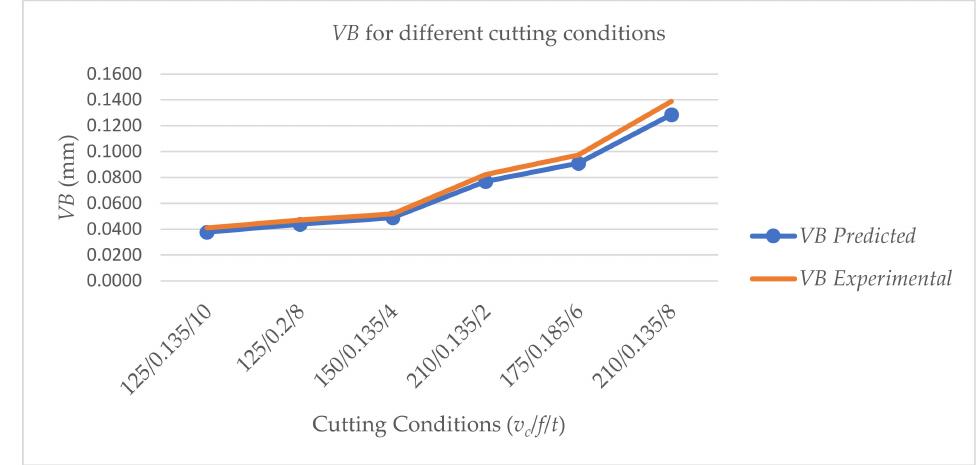
Figure 7. Prediction of flank wear randomly at various combinations of v c , f , and t